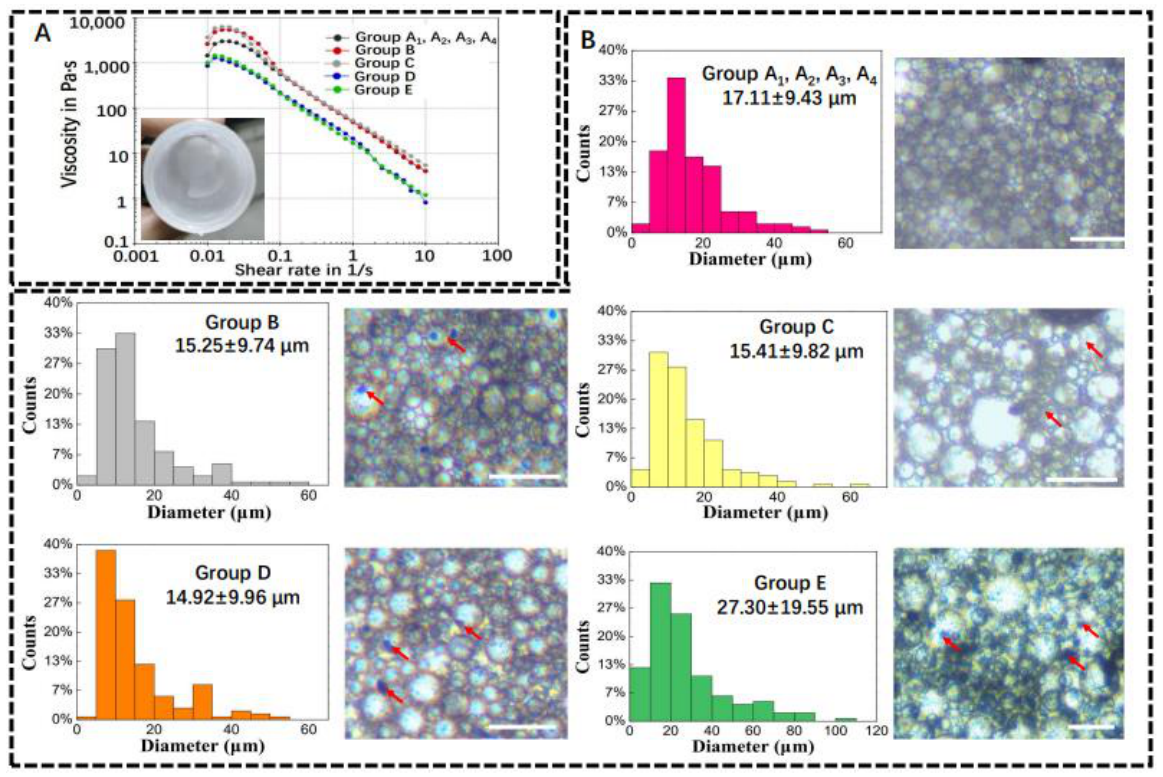
Figure 2. Physical properties of w/o Pickering emulsion inks. ( A ) Viscosity–shear rate plot and milky white Pickering emulsion ink. ( B ) Average diameter of water droplets in Pickering emulsion inks and their representative images. Red arrows represent β -TCP ( n = 150). Scale bar is 100 μm.